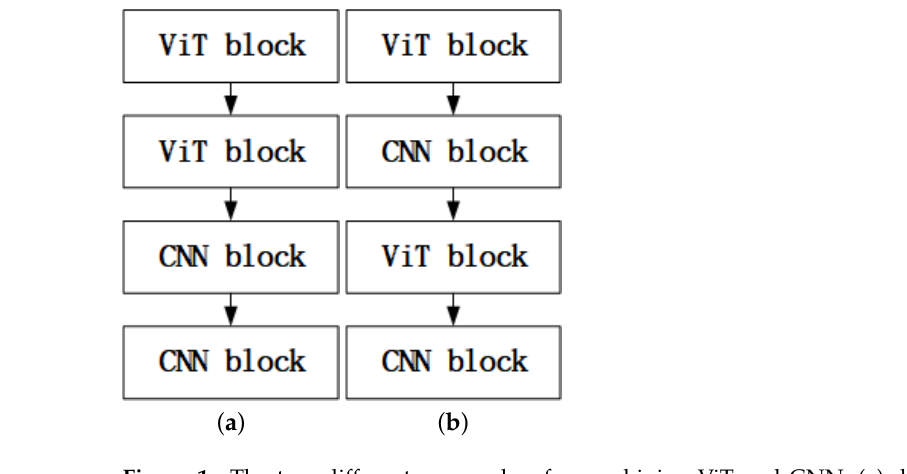
Figure 1. The two different approaches for combining ViT and CNN: ( a ) denotes the separate approach and ( b ) denotes the mixed